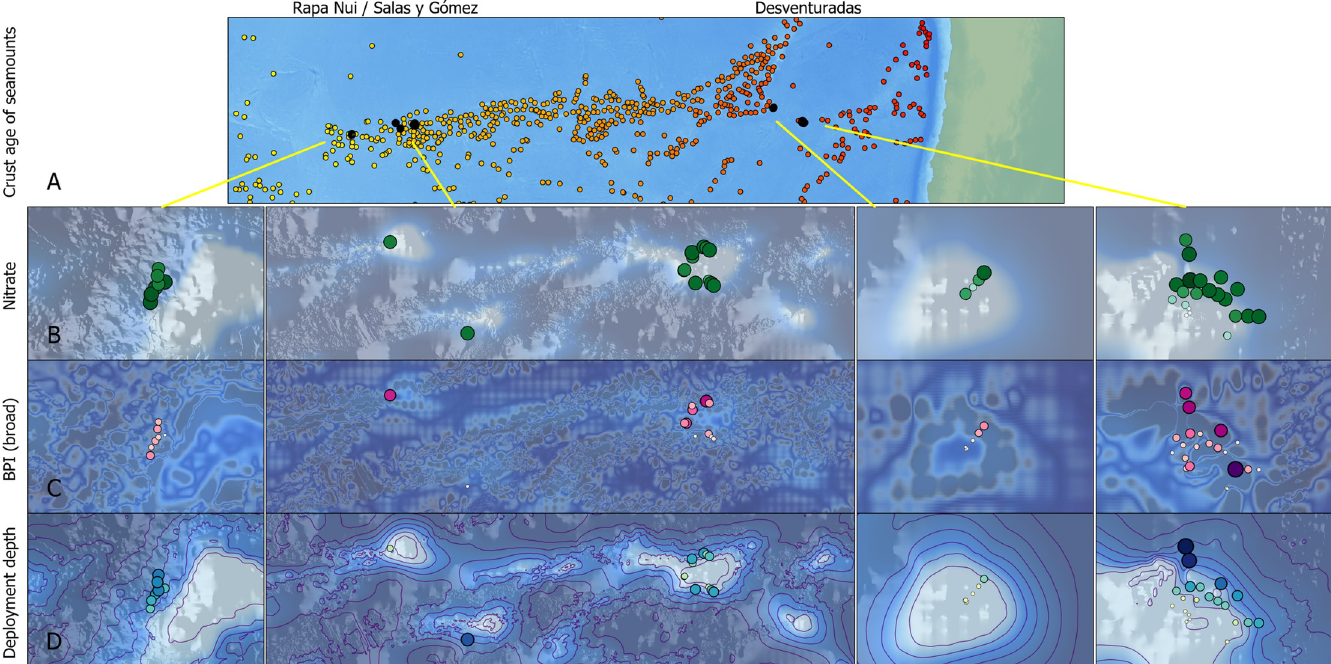
Fig 6. Environmental variables at the deep-sea camera system deployment locations. (A) Crust age (younger ! older: yellow ! red) was extracted for the nearest seamount to each deployment location. (B) Nitrate levels; bubbles depict nitrate levels at deployment location and depth (low ! high nitrate: small/light ! big/dark). (C) Absolute broad-scale bathymetric position index (BPI); bubbles depict absolute BPI values at deployment location (low ! high BPI: small/light ! big/dark), basemap depicts absolute BPI values of region (low ! high: dark blue ! gray). (D) Depth of each deployment; bubbles depict depth at deployment location (small/light ! big/dark: shallow ! deep), basemap depicts bathymetry (deep ! shallow: dark blue ! white). Purple lines in Panel D are 500 m contour lines. Bathymetric data source: Global Multi-Resolution Topography (GMRT) [80,